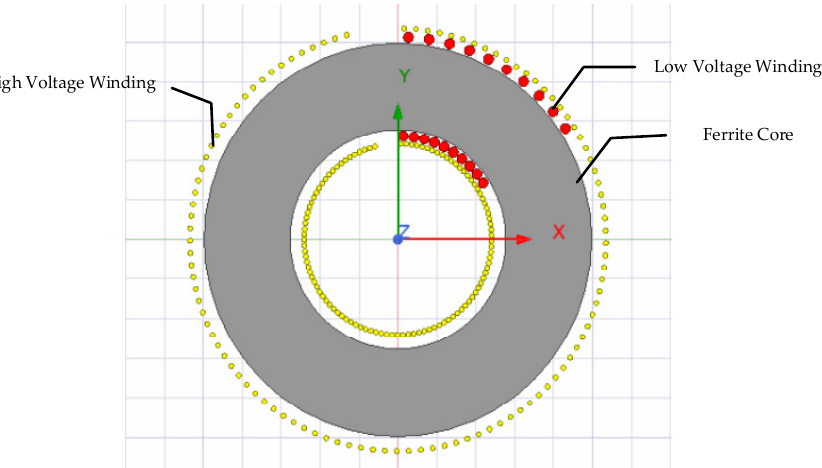
Figure 2. 2D Model of a toroidal transformer.